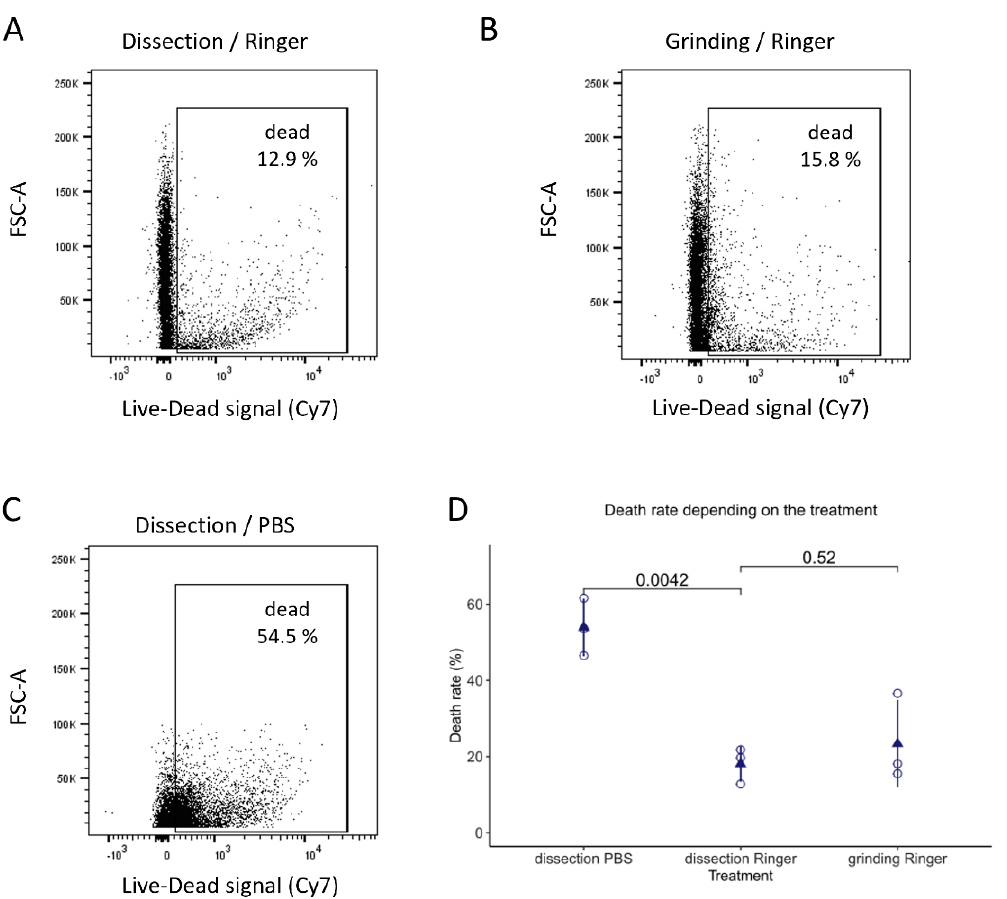
Figure 3. Effects of buffer and disc recovery method on cell viability. Wing imaginal discs obtained by either dissection ( A , C ) or grinding ( B ) in 1X Ringer ( A , B ) or 1X PBS ( C ) were dissociated, filtered through a 40 μm sieve , and stained with a viability dye (Fixable Viability Dye eFluor™ 780) that enters damaged cells with a permeabilized membrane. The dye intensity was measured by flow cytometry (635 nm) to assess the death rate (expressed in % of the total number of individual cells). ( A – C ) Cytograms correspond to FSC = cell size versus Live-Dead signal (Cy7). ( D ) The experiment was performed three times, and each point on the dot plot represents the death rate for one experiment. The triangular point represents the mean for each data set. Statistical significance was determined by one-way ANOVA using Bonferroni ’ s correction for multiple comparison testing.